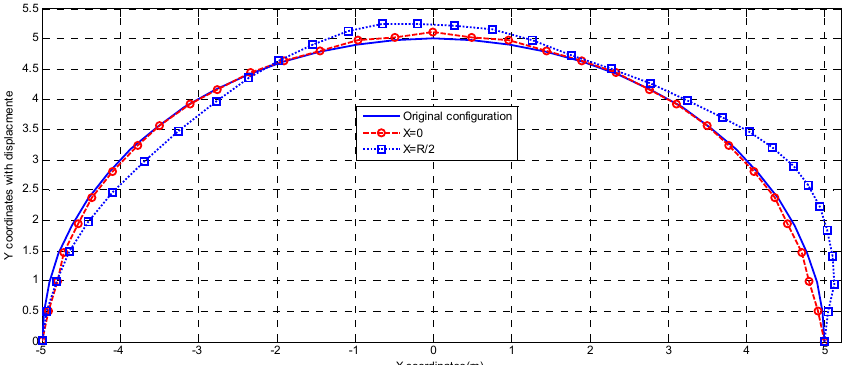
Figure 24. The configuration of the shell with displacement multiplied 50 times, t = 1.30 s.